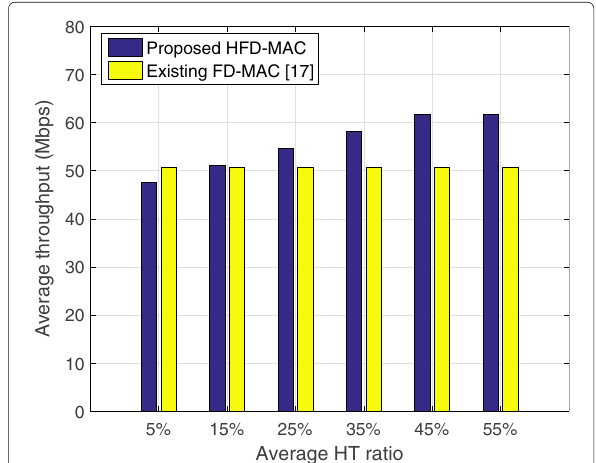
Fig. 13 Average throughput with respect to average HT